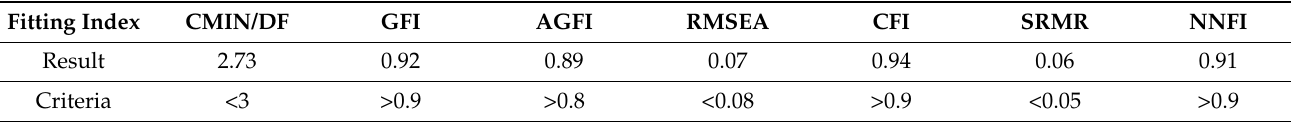
Table 5. Model fit.